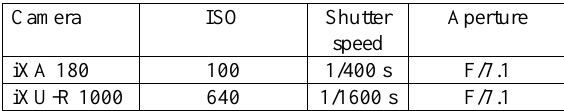
Figure 5. iXU-R 1000 without FMC